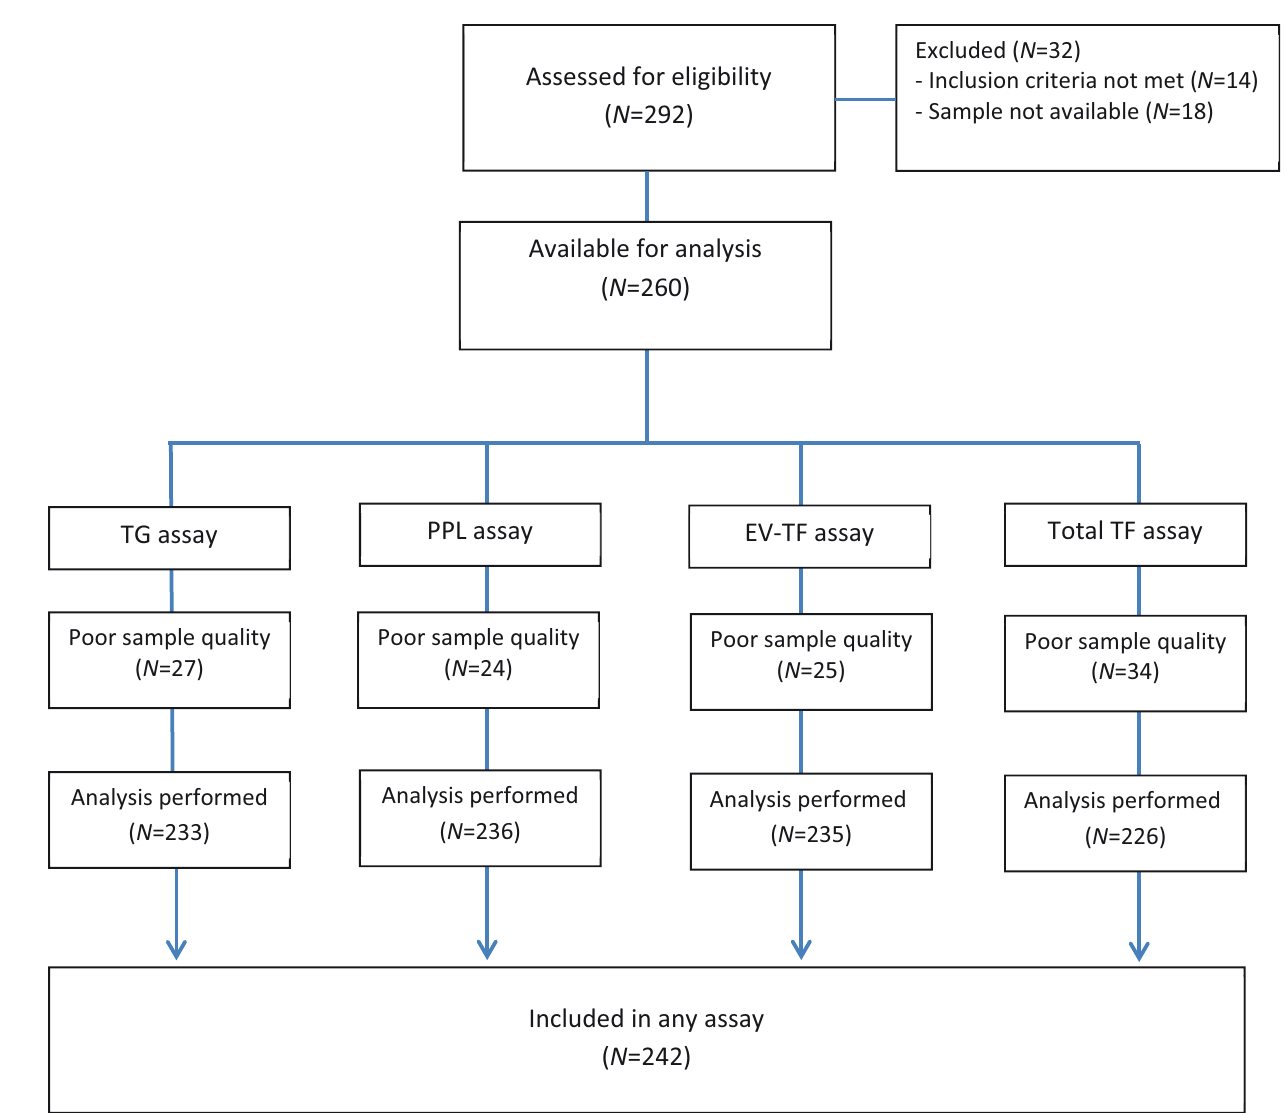
Fig 1. Consort diagram of the study